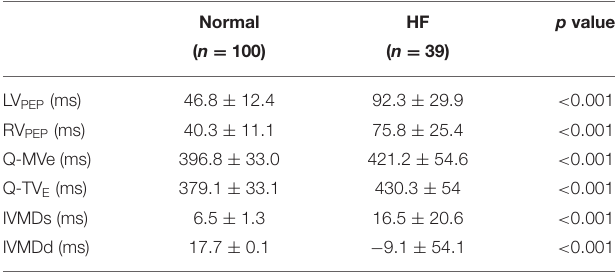
TABLE 3 | Ventricular mechanical delays compared in normal and failing human hearts.